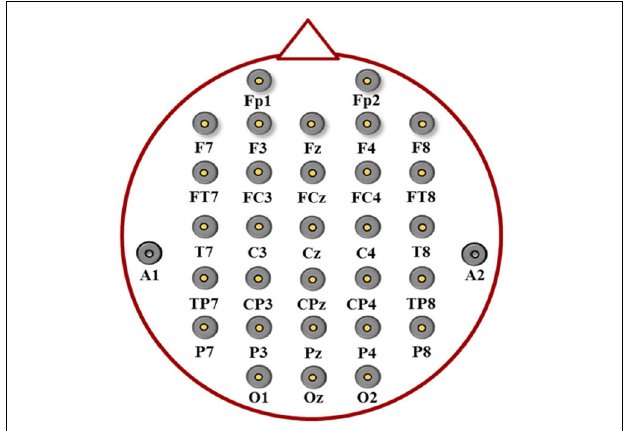
FIGURE 1 | Electrode placements of 32 channels according to the international 10–20 system.